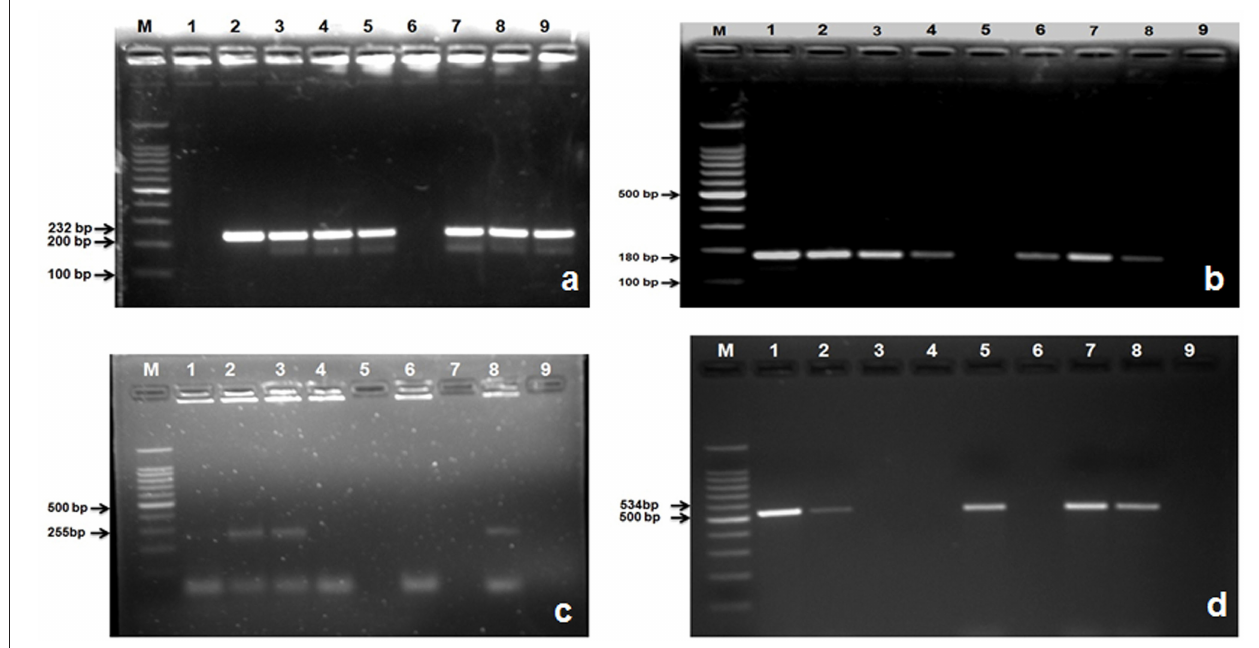
FIGURE 5 | Amplified PCR products of E. coli gene isolated from mastitis milk samples. (a) PCR product of E. coli gene at 232 bp. Lane M: 100 bp ladder; Lane 1: negative control; Lanes 2: positive control; Lane 3, 4, 5, 7, 8, and 9: are E. coli gene positive; Lane 6: is E. coli gene negative; (b) PCR product of stx1 gene at 180 bp. M: 100 bp ladder; Lane 1: positive control; Lanes 2, 3, 4, 6, 7, and 8: are stx1 gene positive; Lane 5: is stx1 gene negative; Lane 9: negative control; (c) PCR product of stx 2 gene at 255 bp. M: 100 bp ladder; Lane 8: positive control; Lanes 2, 3: are stx 2 gene positive; Lane 1, 4, 6, 7, and 5: are stx 2 gene negative; Lane 9: negative control; (d) PCR product of hly gene at 180 bp. M: 100 bp ladder; Lane 1: positive control; Lanes 2, 5, 7, 8: are hly gene positive; Lane 3, 4, 6: are hly gene negative; Lane 9: negative